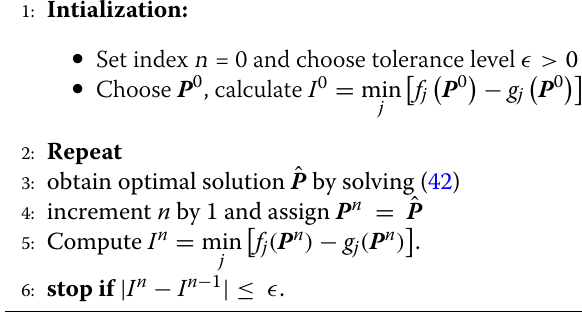
Algorithm 1 Iteratve algorithm for OPA based on SCP: multi-hop